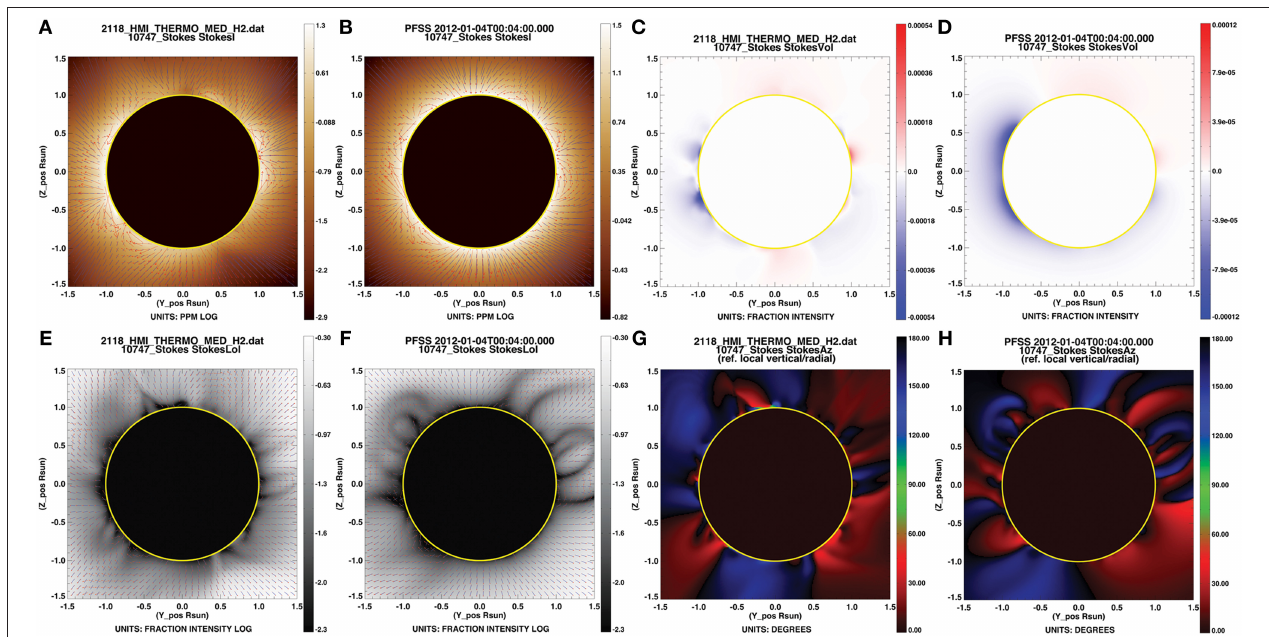
FIGURE 6 | Synthetic polarimetric data from MAS (A,C,E) and PFSS (B,D,F) models. (A,B) Intensity of Fe XIII 1074.7 Å infrared line, with POS magnetic vectors (red) and linear polarization vectors (blue). Plot for (A) obtained in a similar manner as Figure 2 , i.e., for_drive,'psimas',date='2012-01-04',ngrid=256, ngy=256,/comp,/fieldlines,/stklines,/savemap,mapname='psimas_10747_01042012' . The savemap keyword creates an IDL save set (used in plots to follow) which contains information of the full Stokes vector. (C,D) Percent circular polarization V / I . Plot for (C) obtained by for_drive,readmap= 'psimas_10747_01042012',line='VoI' . (E,F) Percent linear polarization L / I , with magnetic and linear polarization vectors (length not scaled by magnitude). Plot for (E) obtained as for V / I but with line='LoI' set, and additional keywords, /fieldlines,bscale=-.6,/stklines,pscale=-.2 . (G,H) Direction Az of linear polarization vector in local vertical (radial) reference frame. Plot for (G) obtained as for V/I but with line='Az' set. Plots for (B,D,F,H) are obtained as for (A,C,E,G) , substituting pfss for psimas